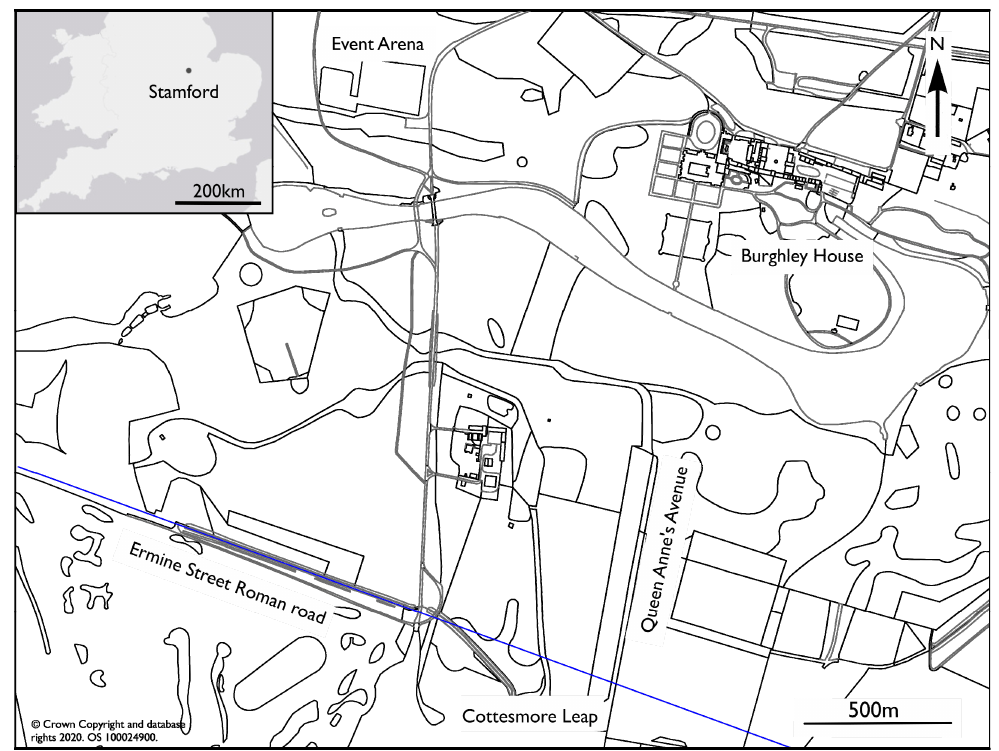
Figure 1. Location of the study site near Stamford, Lincolnshire, UK (inset) together with a plan of the Burghley Estate. The equine locomotion study was conducted over a test site in the vicinity of the Cottesmore Leap to the south of the estate where the presumed course of the Ermine Street Roman road is marked by a blue line.